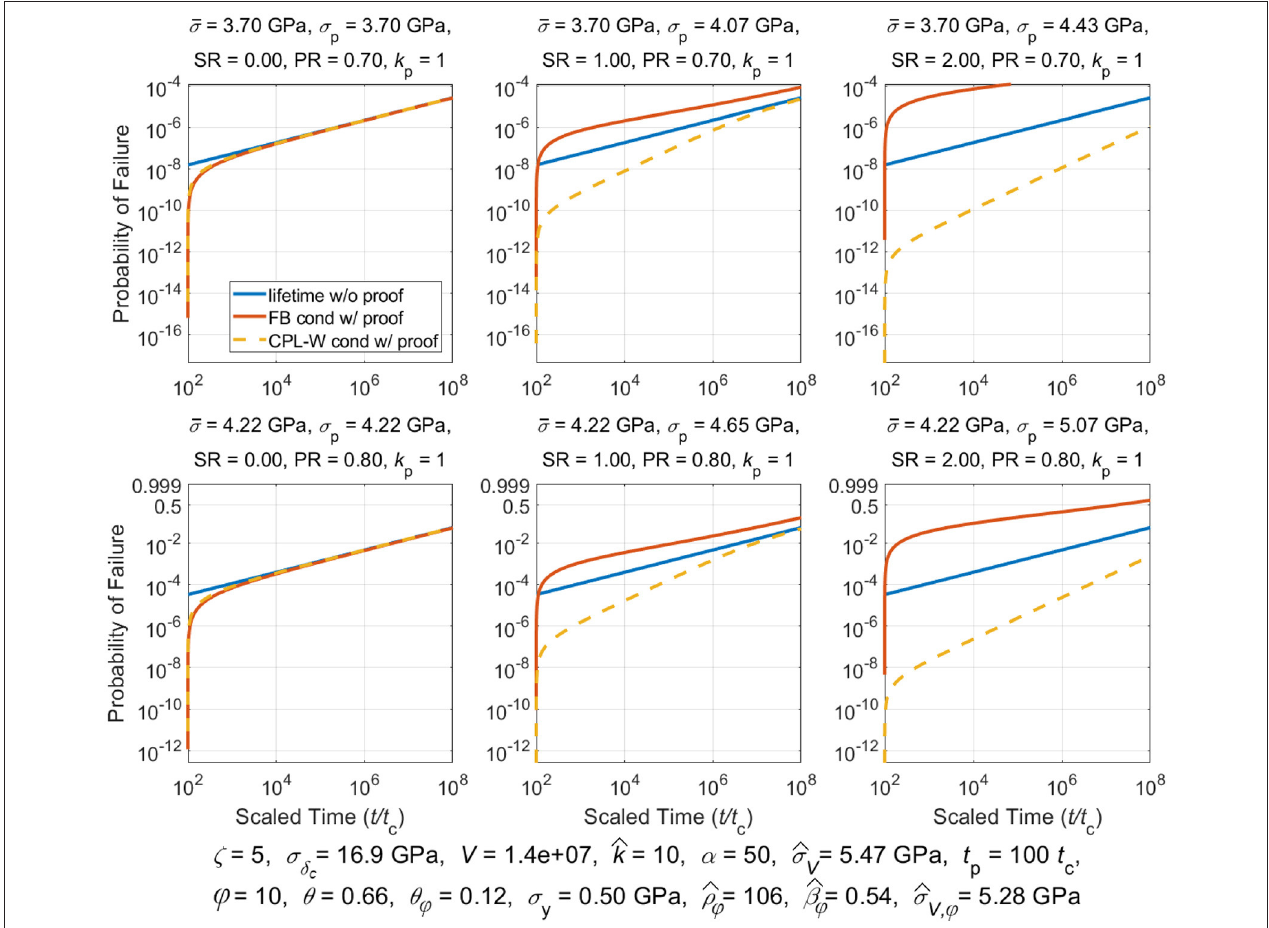
FIGURE 6 | Tow lifetime distribution with fibers arranged in a hexagonal array with number of overloaded neighbors following (56), and with matrix parameters ϕ and σ y =